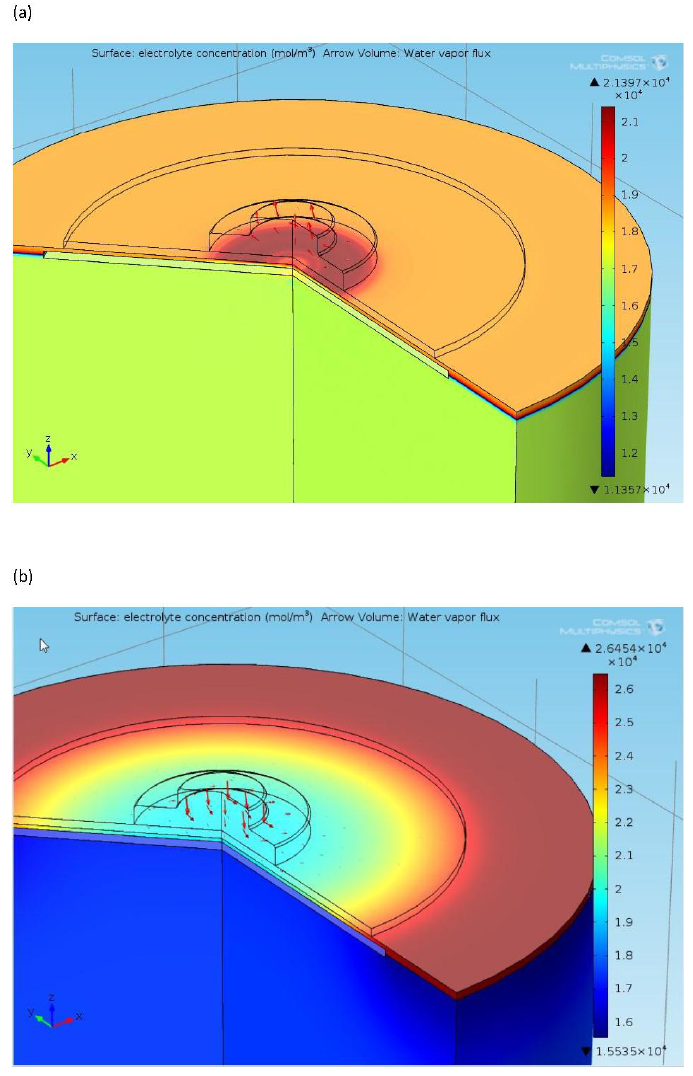
Figure 7. Examples of electrochemical sensor water management model outputs. Spatial electrolyte distributions showing water vapor fluxes at ( a ) 20% RH; 50 °C and ( b ) 80% RH, 10 °C.